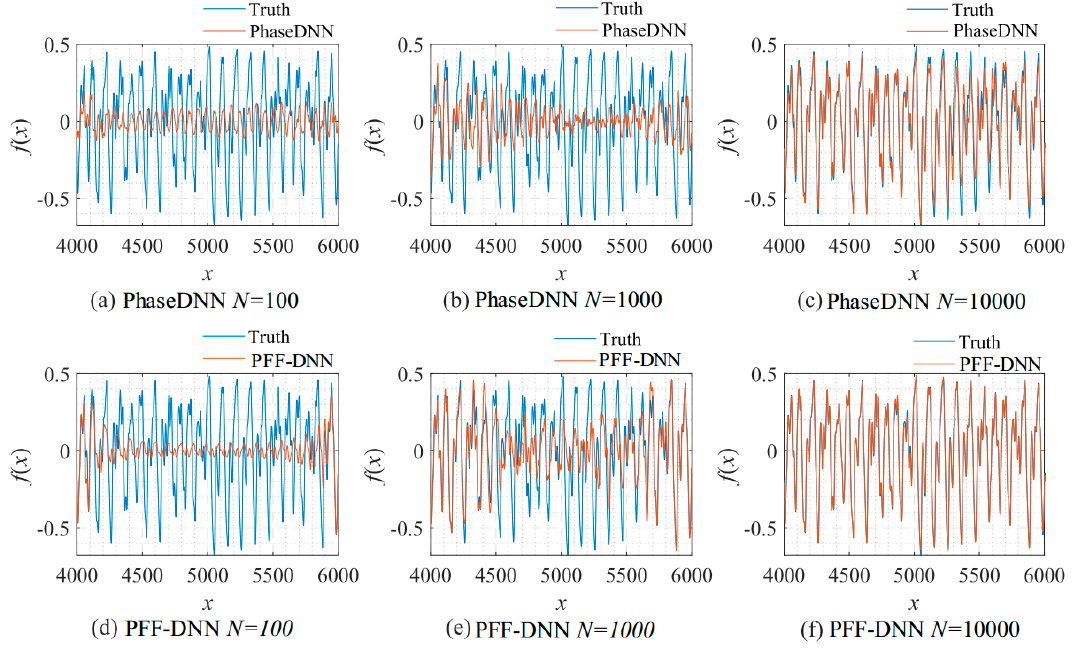
Figure 29. The influence of N on the algorithm performance. Fitting results of the PhaseDNN method when Δ ω = 11: ( a ) N = 100; ( b ) N = 1000; and ( c ) N = 10,000. Fitting results of the PFF-DNN method when Δ ω = 11: ( d ) N = 100; ( e ) N = 1000; and ( f ) N = 10,000. From this example, it is observed that when the signal’s frequency spectrum is rela- tively complicated, the performance gain of the PFF-DNN method was not significant. Therefore, we believe that the PFF-DNN and PhaseDNN methods may have their advan- tages for different